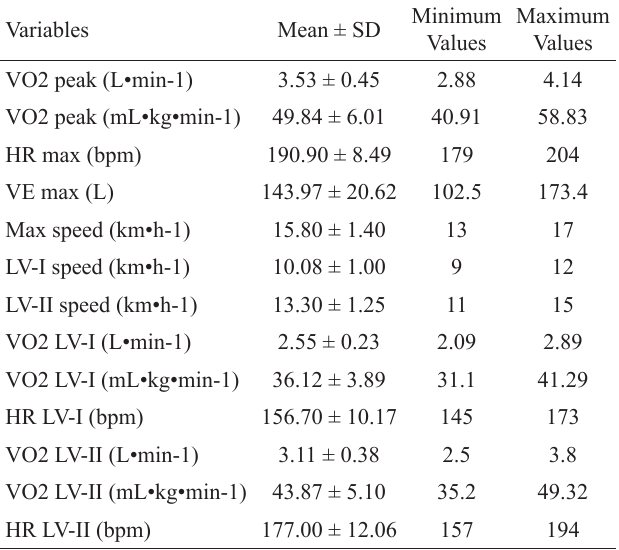
test performed at maximum voluntary